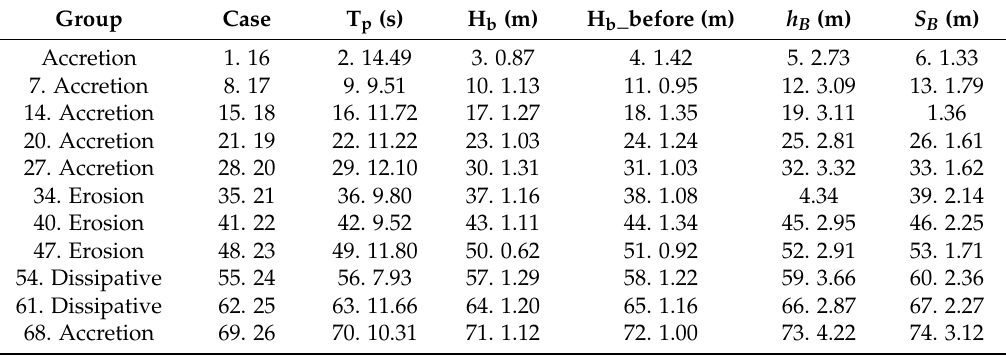
Table 1. Wave data parameters used in the non-dimensional beach response models to a